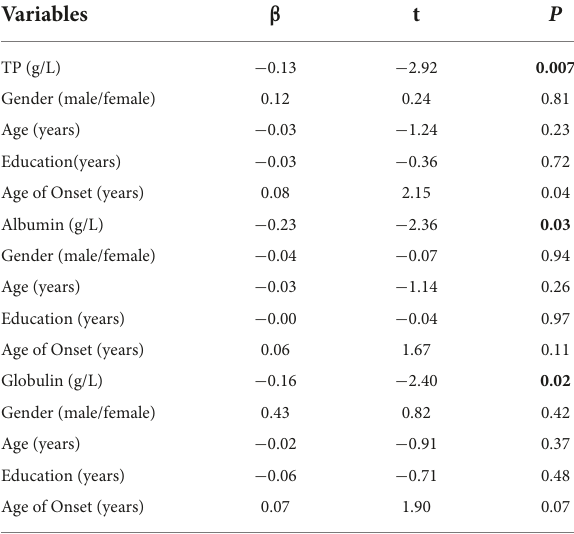
TABLE 2 A stepwise multivariate regression model of social-demographics, serum TP, albumin, and globulin determinants of the Positive and Negative Syndrome Scale (PANSS) depressive symptom score in patients with SCH, respectively.